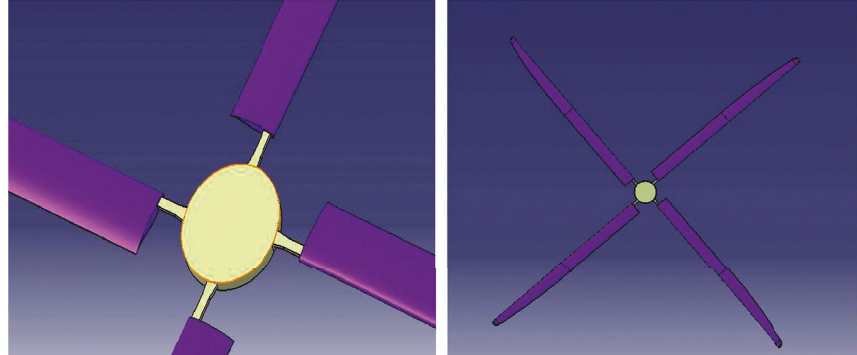
Figure 3: NASA SC(2)-0714 rotor